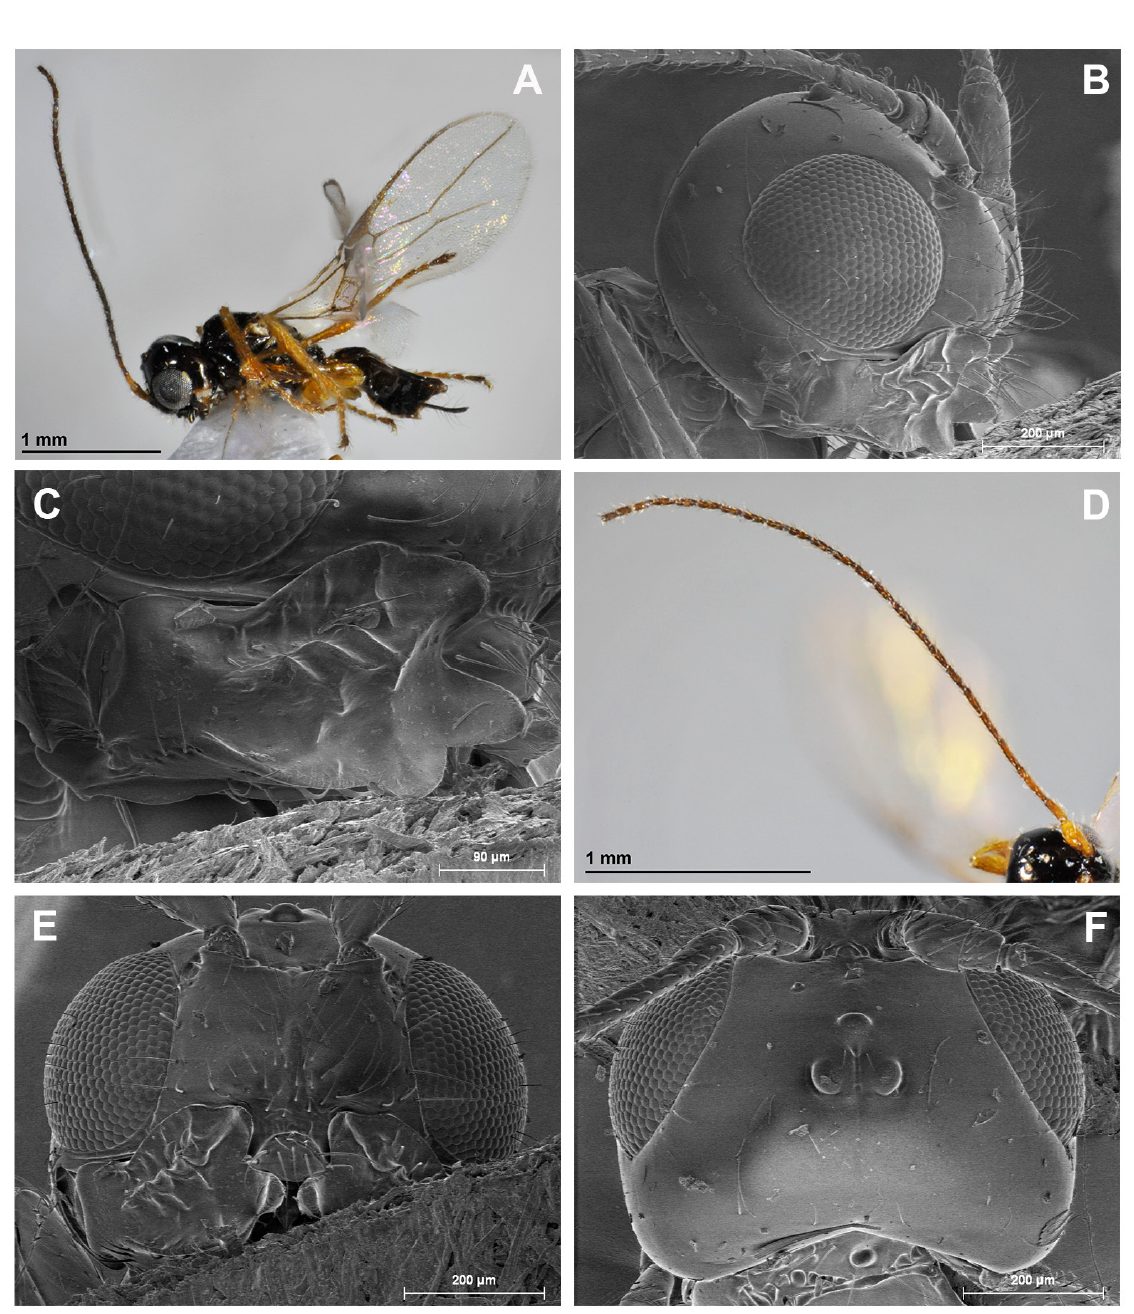
Fig. 64. Asobara transversaria Fischer, 2007, ♀, holotype (OLML). A . Habitus, lateral view. B . Head, lateral view. C . Mandible. D . Antenna. E . Head, front view. F . Head, dorsal